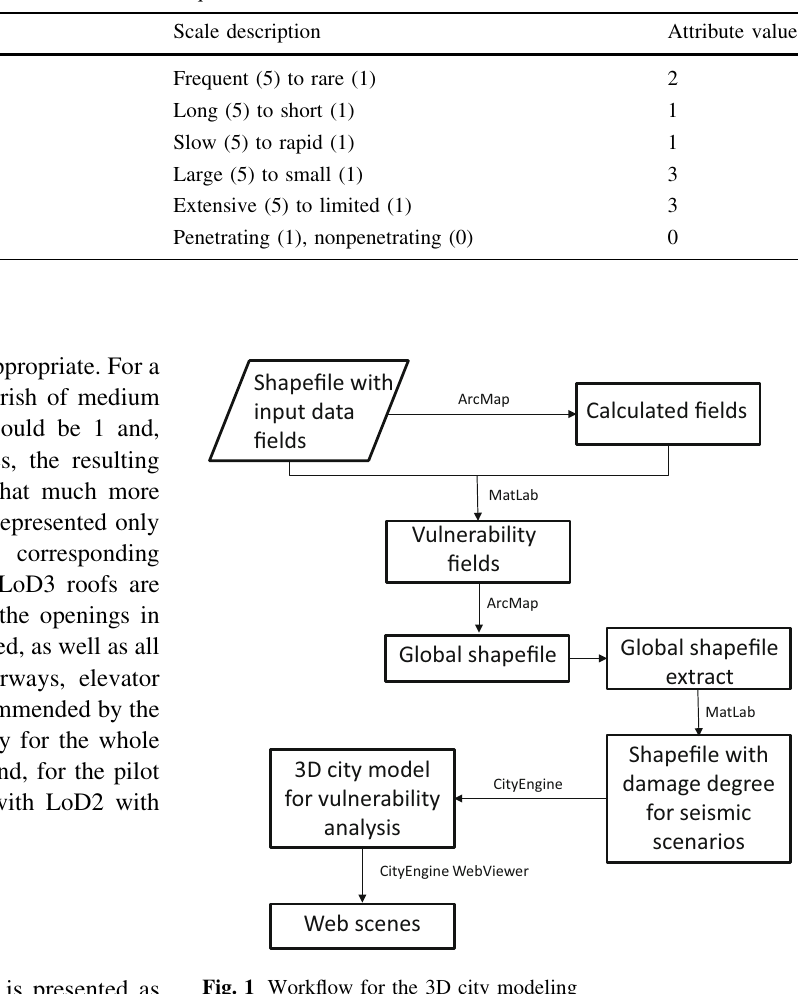
Fig. 1 Workflow for the 3D city